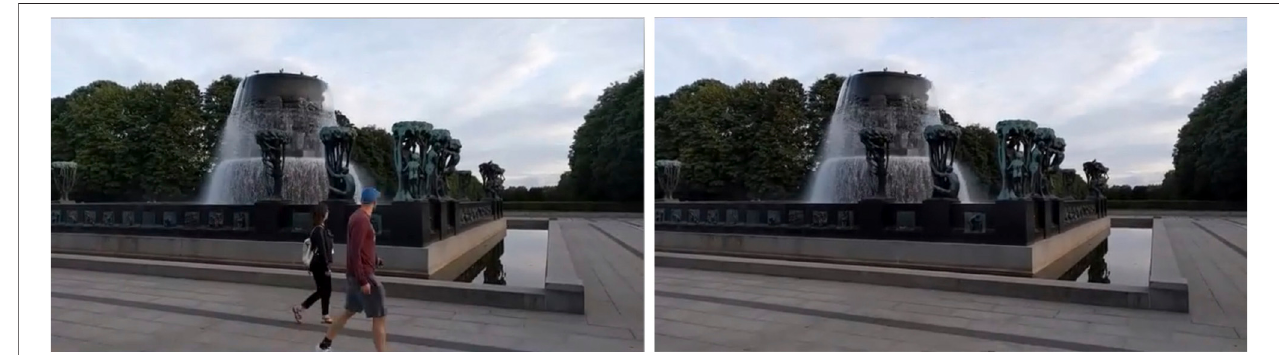
FIGURE 4 | Removal of persons from a video. A manipulation of the image on the right is not visible here. Source: Still from a video created by the authors using NVIDIA Inpainting (NVIDIA,